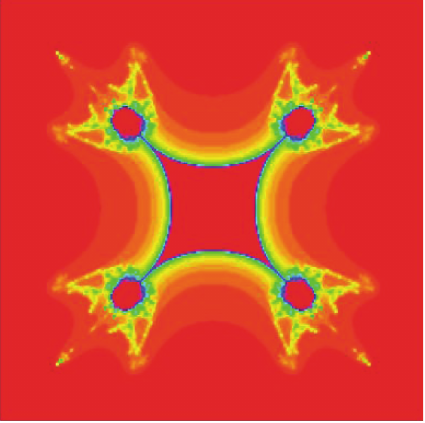
Figure 6: Relative superior tricorn for 𝑠 = 0.3 and 𝑠 󸀠 = 0.7 .